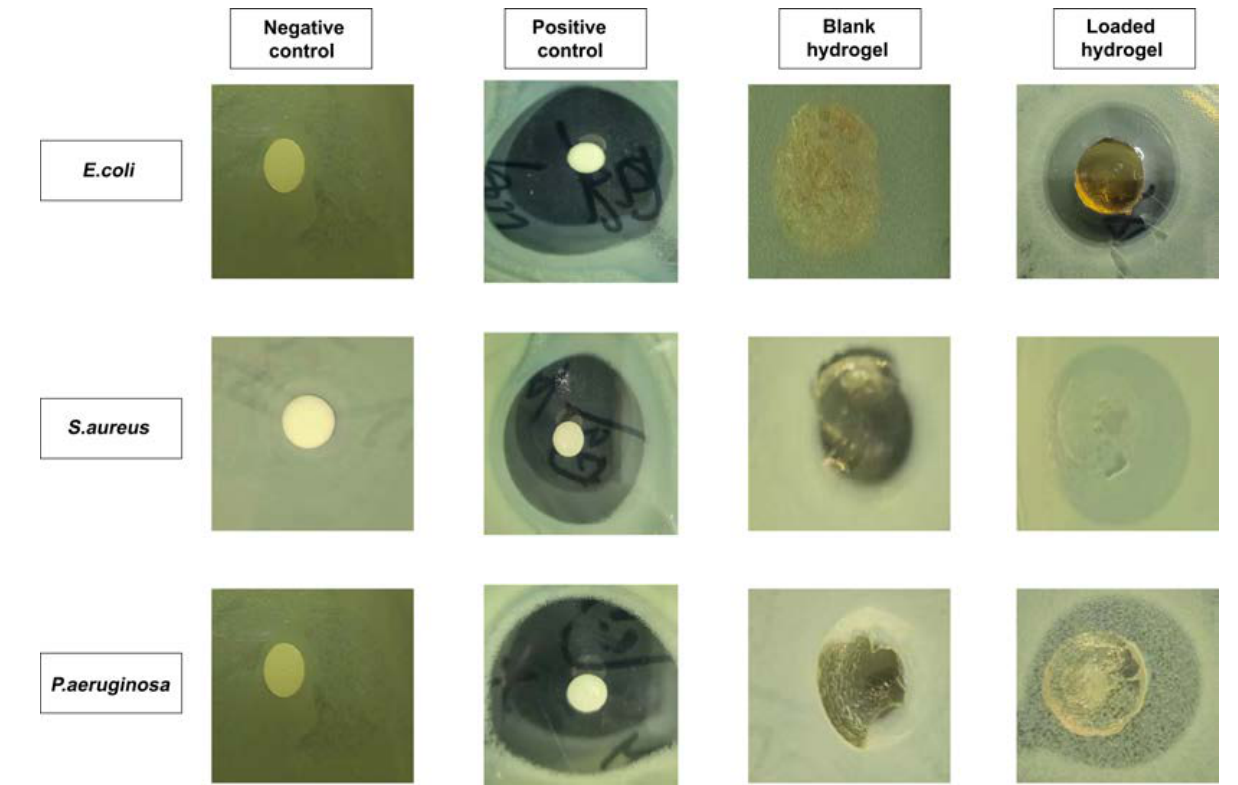
Figure 8. Zones of inhibition of the CS- g -AMPS hydrogels against three types of bacteria.